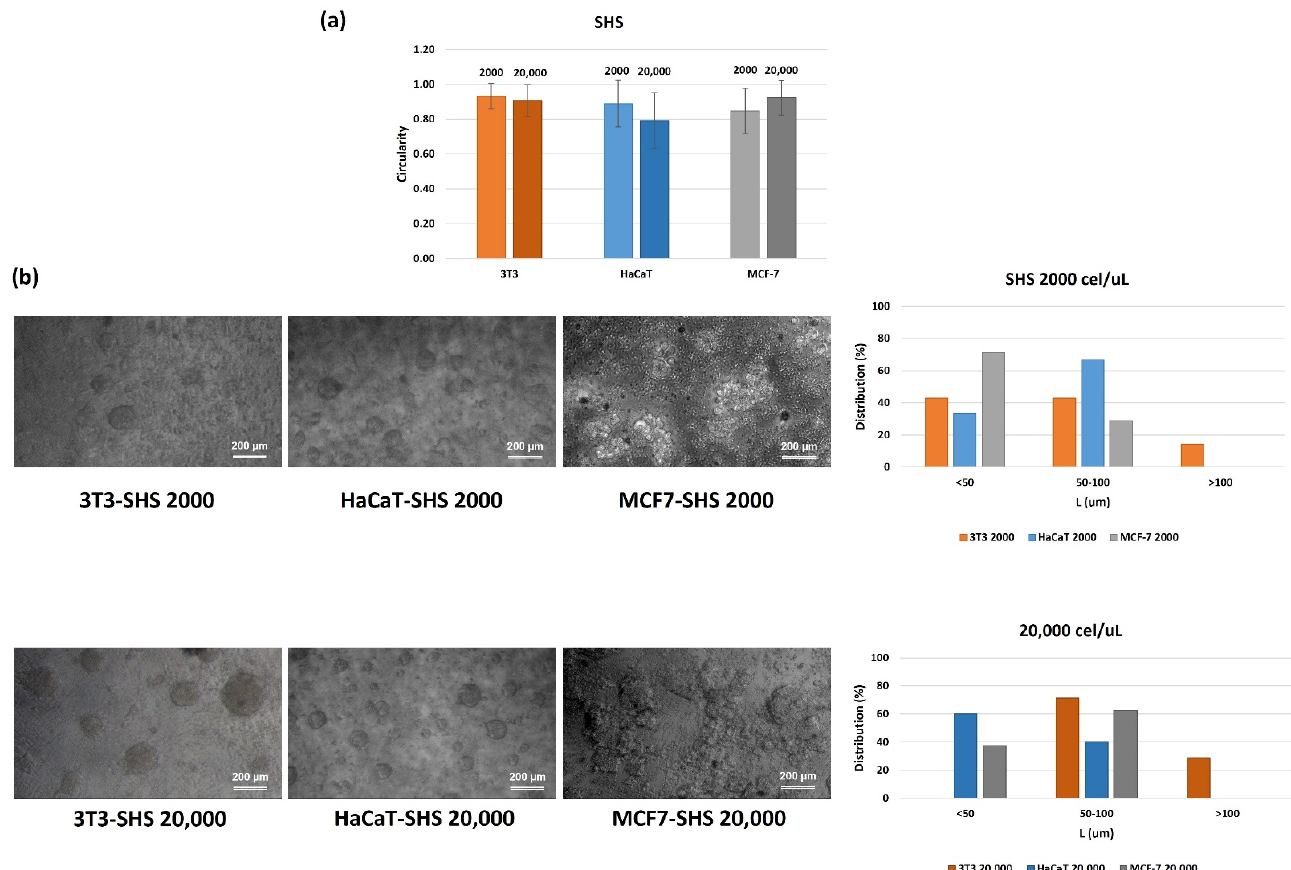
Figure 3. Circularity values ( a ) and representative phase-contrast images and size distribution of spheroids ( b ) as a function of the initial cell density (either 2000 cell/µL or 20,000 cell/µL) after incubation in SH coating for 24 h. Results are expressed as the average of more than 10 single spheroids ± standard deviation. Scale bars represent 200 µm.